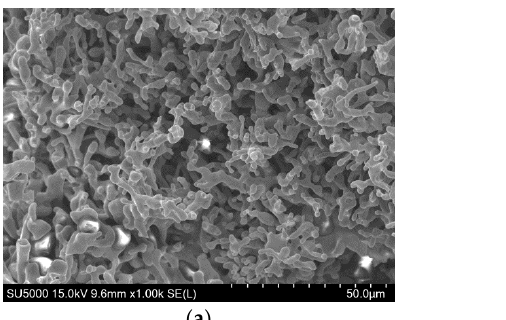
Figure 2. Microstructure of reduced briquettes with different dosage of borax (bright white, metallic iron).